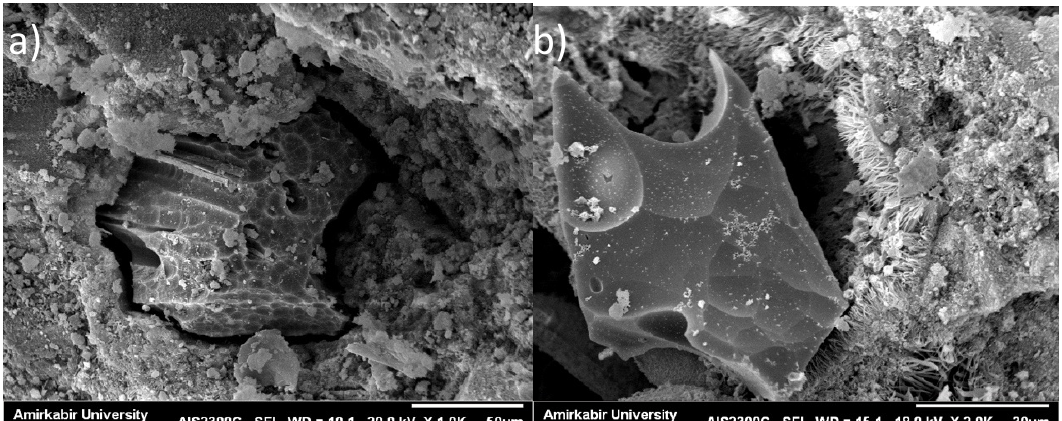
Figure 6. SEM images of: ( a ) CO sample; and ( b ) MK30 sample.